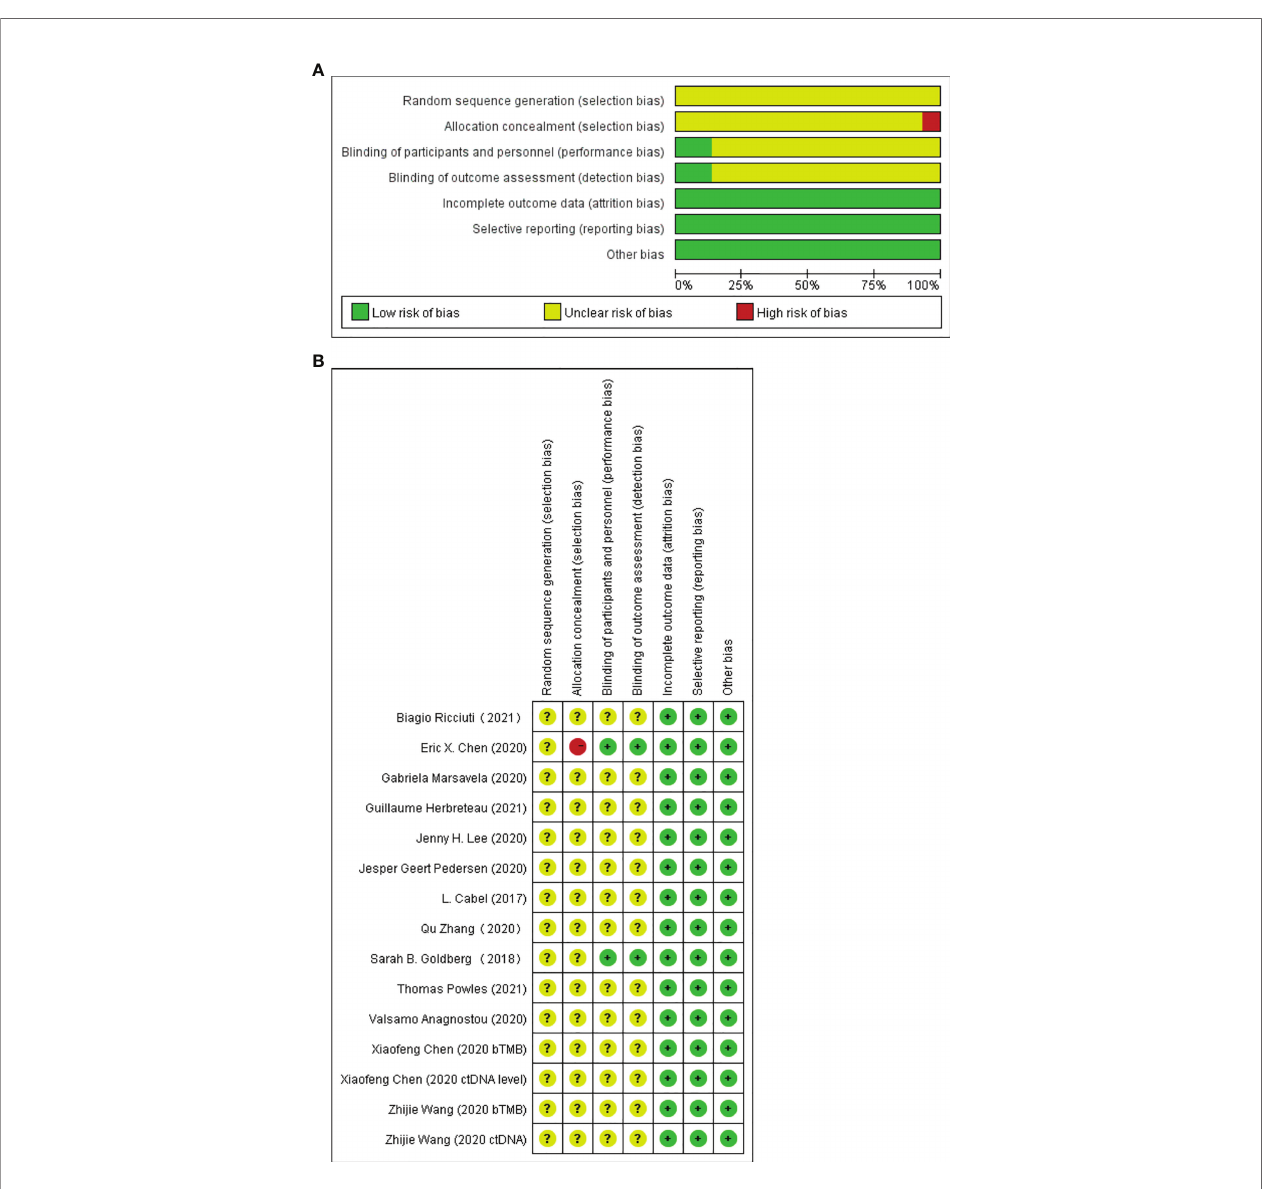
FIGURE 2 | Assessment of risk of bias at the study level. (A) Risk of bias graph: review authors ’ judgments of each risk of bias item presented as percentages across all included full report studies. (B) Risk of bias summary: review authors ’ judgments of each risk of bias